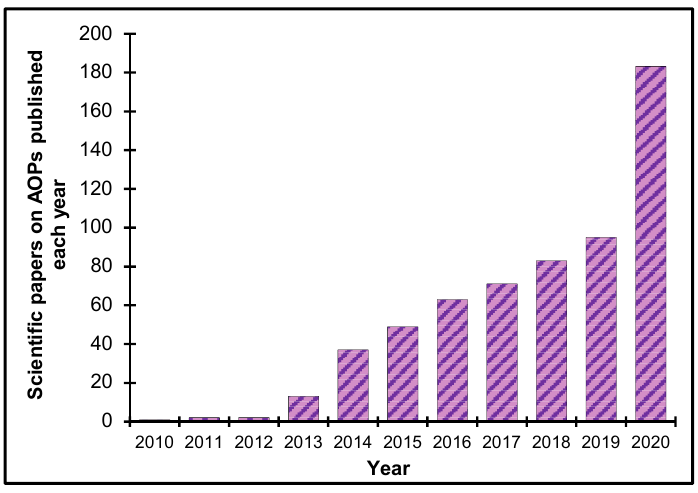
Figure 2. Scientific papers on AOPs published annually, 2010–2019. PubMed was searched for published papers containing the text words “adverse outcome pathway” on 22 May, 2020. The result for 2020 is estimated given the number of publications that have been published per month.